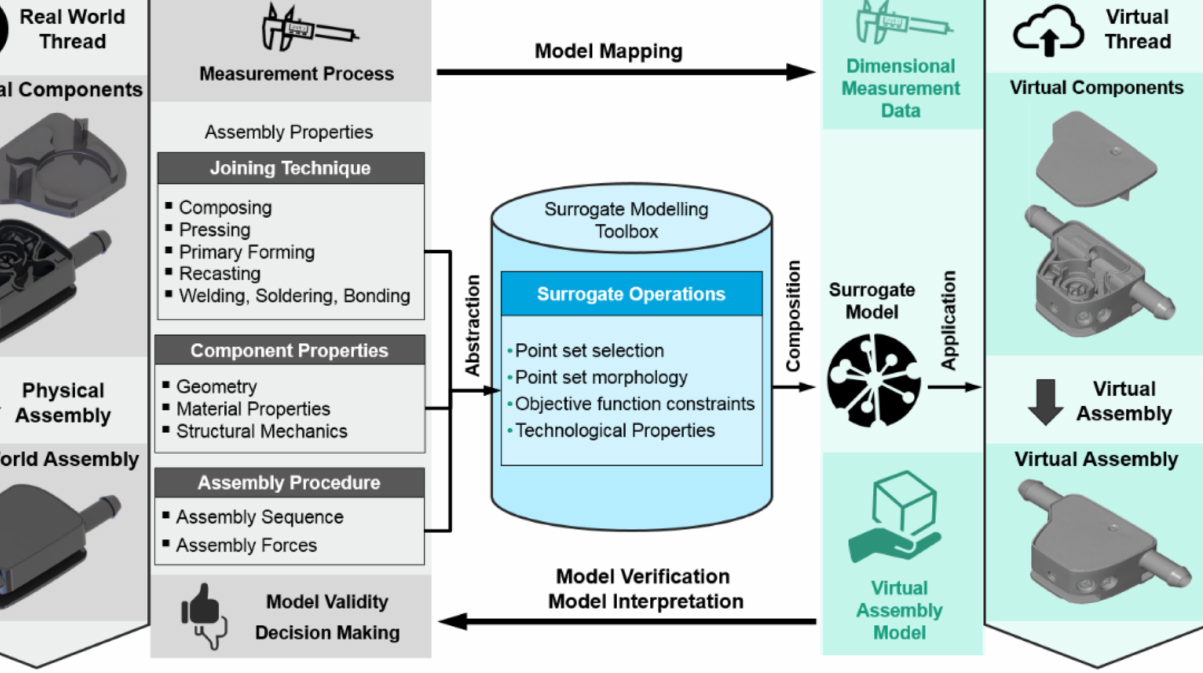
Figure 5. Detailed visualization of the developed concept for surrogate modelling in order to predict the geometrical quality of